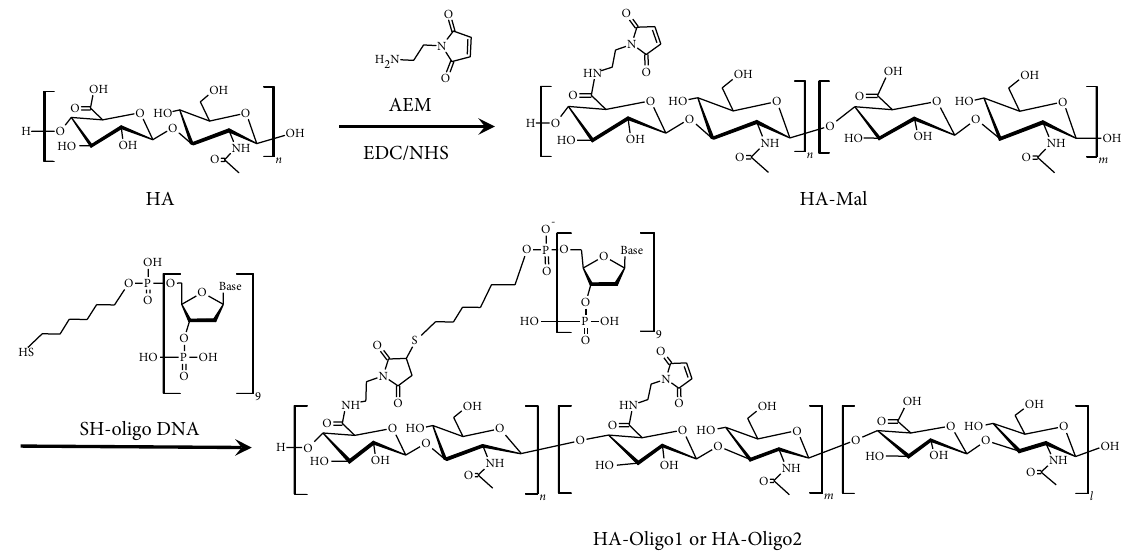
Scheme 1: Modification of hyaluronic acid with thiolated oligo